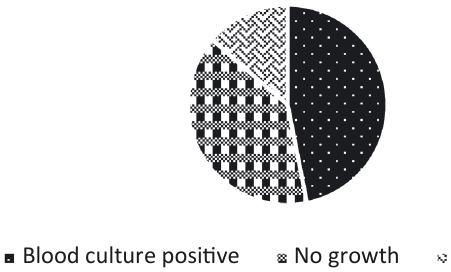
Figure 1: Distribution of blood culture positive among study group